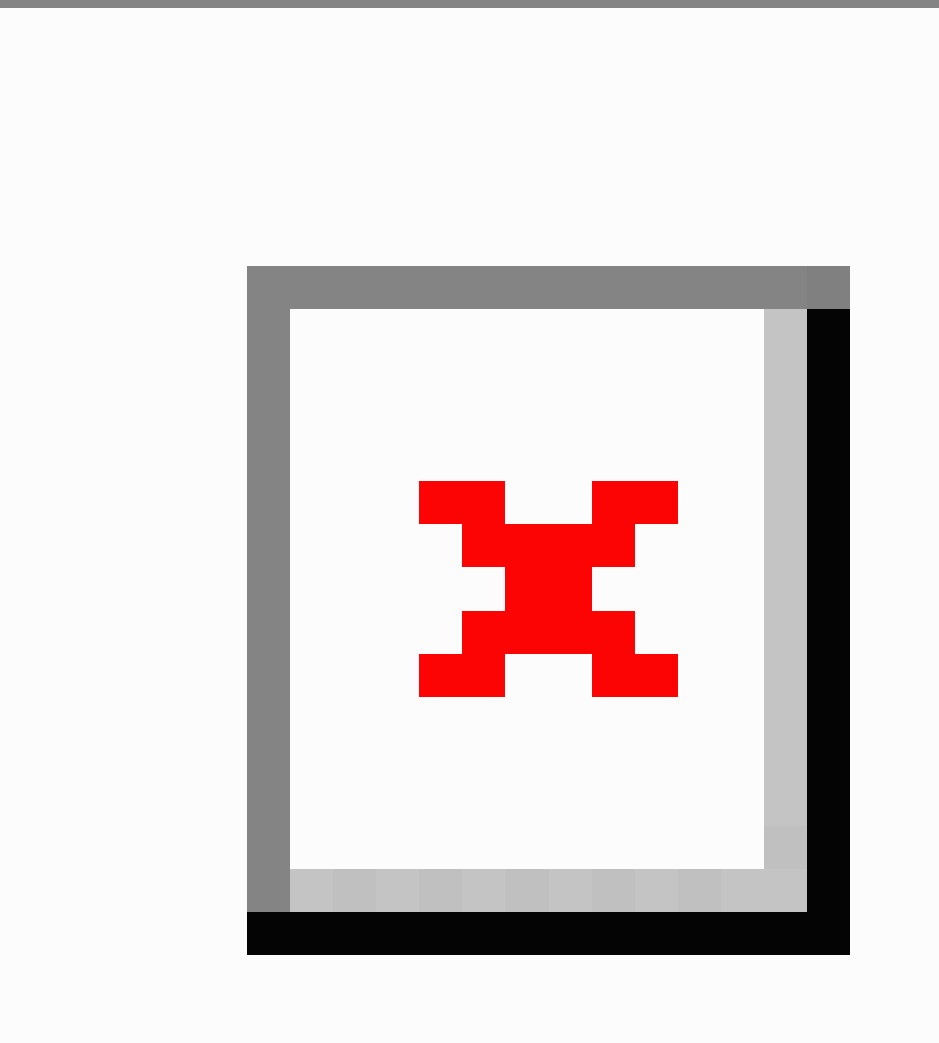
Figure 1. Screen capture of a sample lab